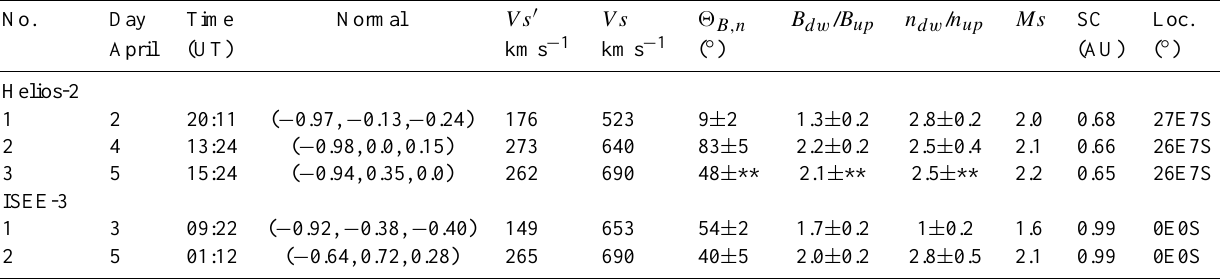
Table 1. Results of the analysis of the April 1979 shocks. Normal is the calculated shock normal. The next column shows the speed of each shock in km/s with respect to the upstream solar wind ( V s 0 ) and in a solar inertial frame ( V s ), 2 B,n is the angle between the upstream IMF vector and the shock normal; B dw / B up and n dw / n up are the compression ratios of the magnetic field strength and the density, respectively; Ms is the sonic Mach number, R and 8 are the heliospheric distance and longitude, respectively. All vector quantities are given in SE coordinates. During the passage of shock S3 at Helios-2 there are only a few data points so we do not derive an estimate of the uncertainty in the RH parameters